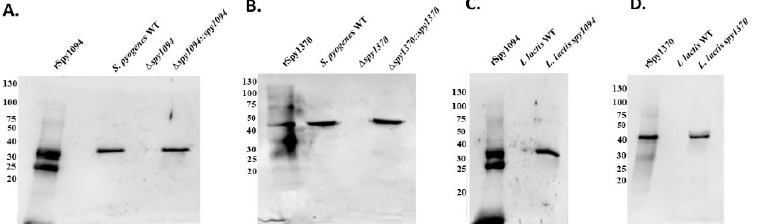
Figure 1. Expression of Spy1094 and Spy1370 in wild-type and mutant strains. Bacterial whole cell lysates were separated on a 12.5% PAGE gel, transferred onto a nitrocellulose membrane and probed with rabbit antiserum against rSpy1094 or rSpy1370. ( A ) Expression of Spy1094 in wildtype and mutant S. pyogenes. ( B ) Expression of Spy1370 in wildtype and mutant S. pyogenes . ( C ) Expression of Spy1094 in wildtype and mutant L. lactis. ( D ) Expression of Spy1370 in wildtype and mutant L. lactis . Recombinant Spy1094 or rSpy1370 were used as positive